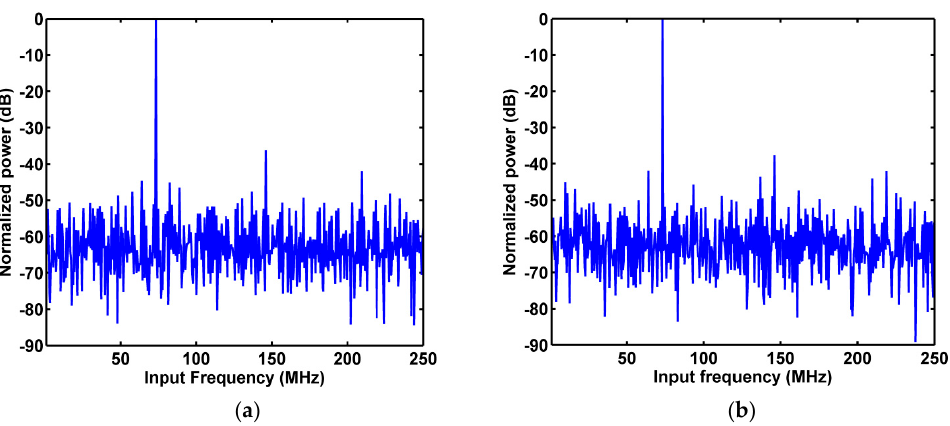
Figure 12. ( a ) Frequency spectrum for the first proposed VTC at F in = 72.75 MHz, and ( b ) frequency spectrum for the second proposed VTC at F in = 72.75 MHz.